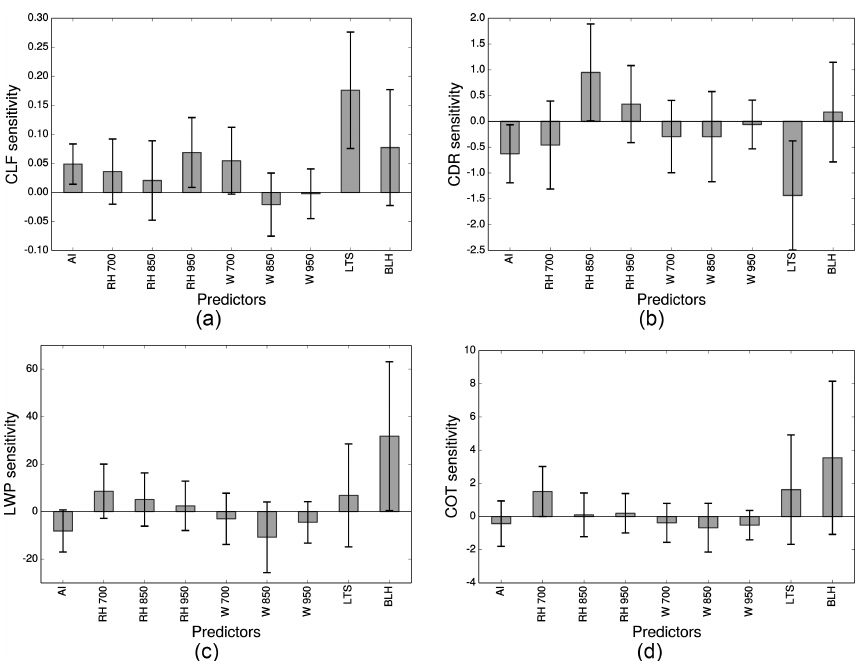
Figure 5. Global mean relative sensitivities as defined in Sect. 2.3 of (a) CLF, (b) CDR, (c) LWP and (d) COT for all predictors of the ANNs ( x axes). Error bars illustrate the regional variability of the sensitivities (global standard